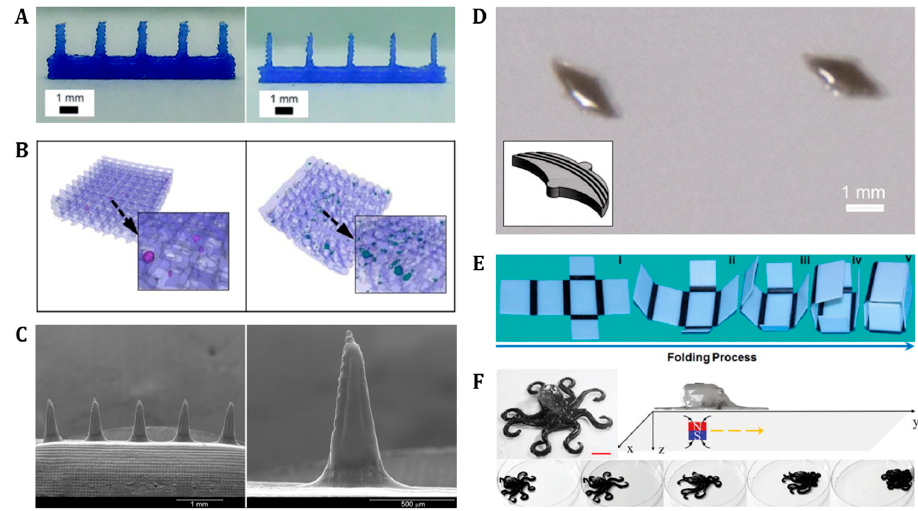
Figure 3. Biomedical applications fabricated by 3D/4D printing . ( A ) 3D Extrusion: Optical images of microneedles fabricated by FDM. Reproduced with permission [118]. Copyright 2018, The Royal Society of Chemistry. ( B ) 3D Extrusion: Scaffolds fabricated by 3D plotting. Reproduced with permission [120]. Copyright 2016, Wiley Periodicals. ( C ) 3D Jetting: Miconazole-loaded Gantrez AN 169 BF microneedle array fabricated by Inkjet. Reproduced with permission [123]. Copyright 2014, Elsevier. ( D ) 3D Jetting: Bat-shaped polymer structure printed by a PolyJet 3D printer. Reproduced with permission [126]. Copyright 2014, The American Society of Mechanical Engineers. ( E )